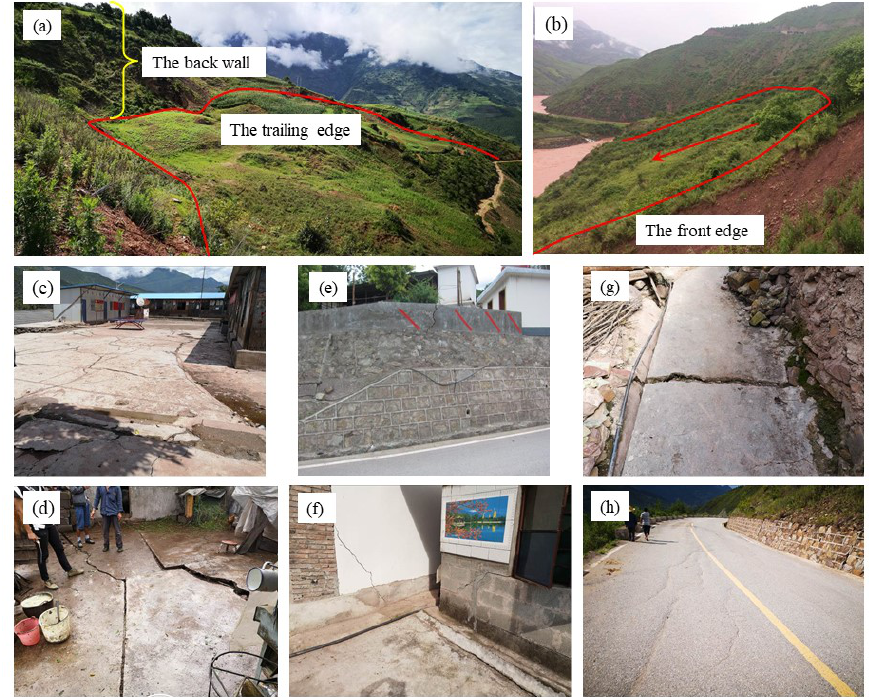
Figure 10. Field survey photos. ( a ) The trailing edge has sunk. ( b ) The front edge has slid. ( c ) Cracks in the Cheyiping primary school. ( d ) Cracks in villagers’ homes. ( e ) Fissures in the walls. ( f ) Cracks in houses. ( g ) Cracks in the road in the village. ( h ) Deformation of Bao–Tibet highway.